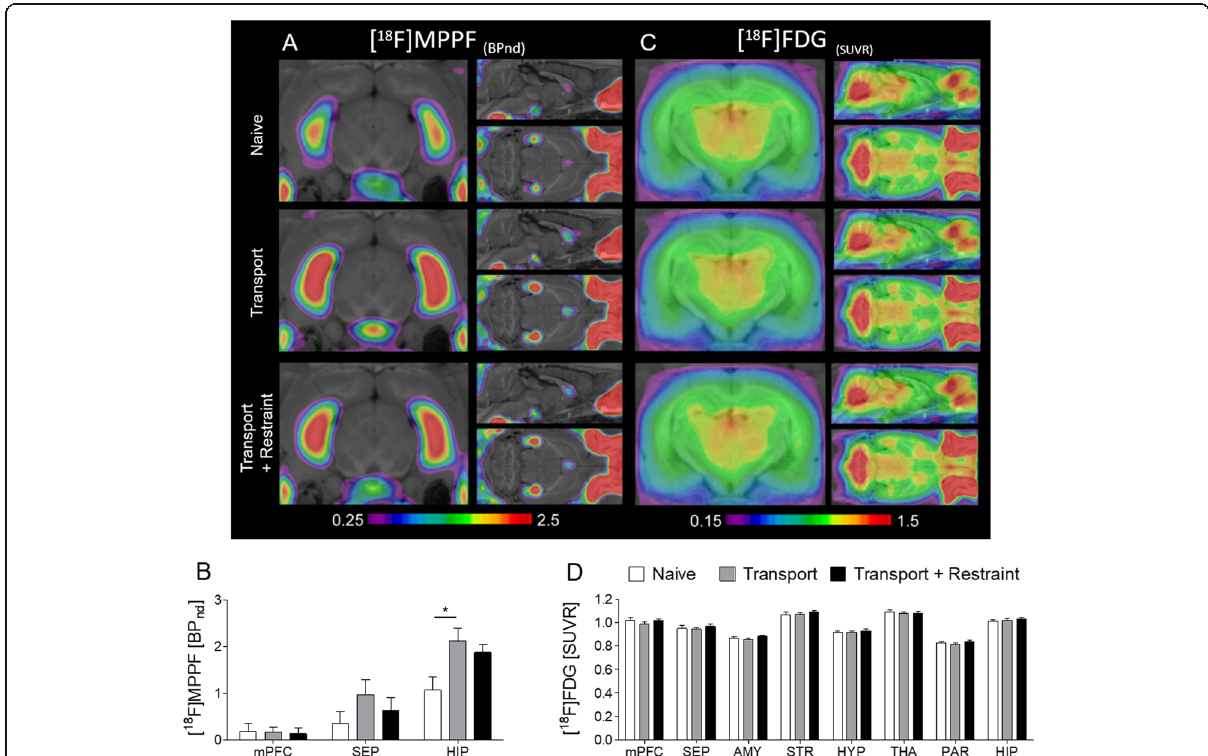
Fig. 2 Cerebral glucose metabolism and 5-HT 1A receptor availability assessed by [ 18 F]FDG and [ 18 F]MPPF μ PET. a Average parametric maps of [ 18 F]MPPF binding potential. b [ 18 F]MPPF binding in the medial prefrontal cortex, septum, and hippocampus. A significant increase of hippocampal [ 18 F]MPPF binding became evident in rats with daily transport to the laboratory and a 1-h stay in the laboratory. c Averaged [ 18 F]FDG metabolic maps. d [ 18 F]FDG uptake did not significantly differ between groups in any brain region of interest. Data are shown as mean ± SEM. * P < 0.05